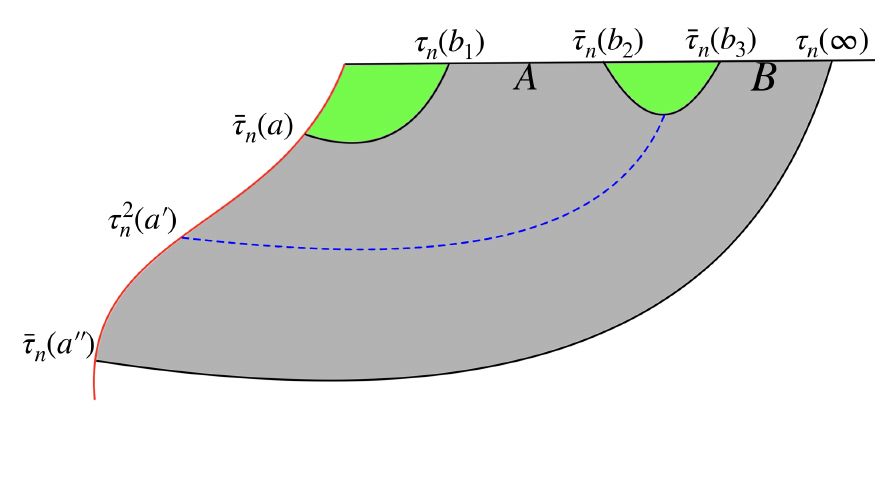
Figure 4: Schematic for island proposal-II for the entanglement negativity of the mixed state configuration of disjoint intervals in phase-I. The gray region here and for the rest of the figures corresponds to the entanglement wedge of the subsystem- AB . The blue dotted line denotes the EWCS in the double holographic picture. The above figure is modified from [ 68 ]